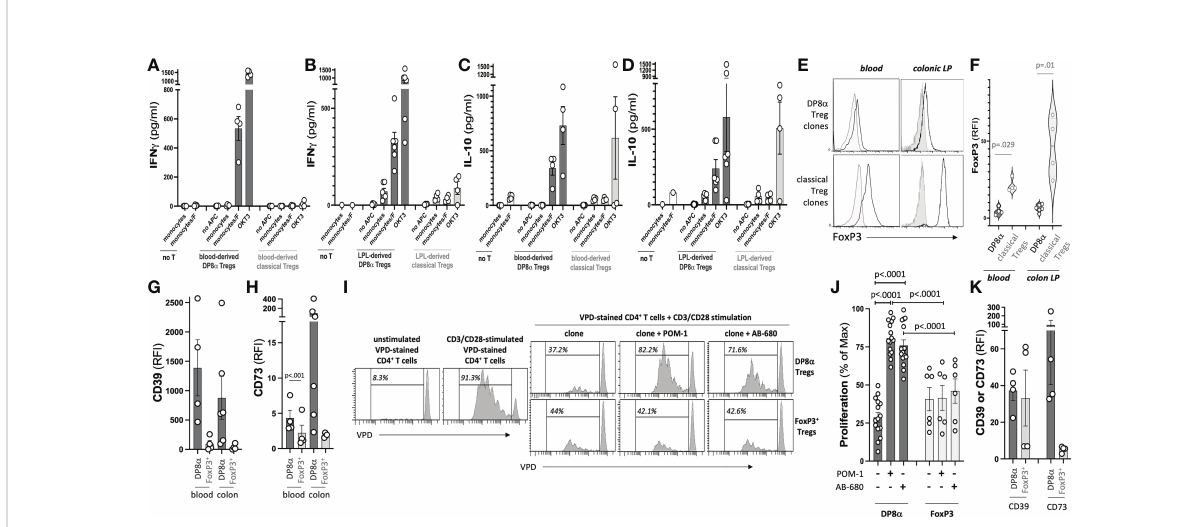
FIGURE 1 Treg clone selection and characterization. The gating strategy to sort F. prausnitzii -reactive DP8 a and classical FoxP3 + Tregs used for clone production is described in the Methods ’ section and shown in Figure S1. (A - D) Clones were screened by ELISA for their IFN g (A, B) and IL-10 (C , D) responses to F. prausnitzii or anti-CD3 stimulation (clone OKT3). (E , F) FoxP3 expression was assessed by intracellular staining. Representative histogram plots examples (left) and all data (right) are shown (G, H) . CD39 (G) and CD73 (H) expression by clones measured using surface immunostaining. (I , J) . CD3/CD28-stimulated VPD-stained CD4 + T cells were co-cultured with Treg clones (ratio 1:1) in the presence or not of CD39 and CD73 inhibitors, namely POM-1 (30 m M) and AB-680 (100nM), respectively, as indicated. Proliferation was evaluated by VPD dilution. Representative histogram plots examples (I) and all tested conditions (i.e., 5 DP8 a clones and 2 FoxP3 + clones each co-cultured with CD4 + cells from 3 distinct donors) (J) are shown. (K) CD39 and CD73 expression by gated CD3 + /CD4 + /CD8 a LOW /CCR6 + / CXCR6 + DP8 a and CD3 + /CD4 + /CD25 HIGH /CD127 LOW classical Tregs among ex vivo PBMCs is shown. RFI corresponds to the ratio: MFI obtained with the relevant antibody over MFI for the corresponding isotype control. Mann-Whitney tests were used for single comparisons, while